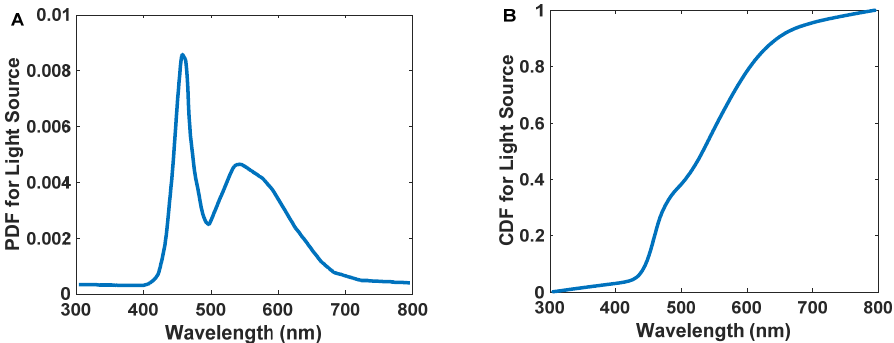
Figure 7. The probability density function ( A ) and cumulative distribution function ( B ) for commercially available white light LED emission spectrums.